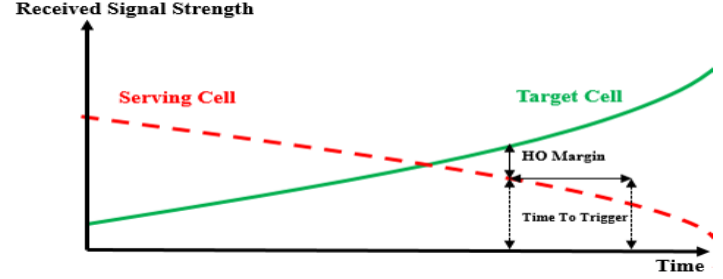
Figure 7. A sketch of near-far effect in different scenarios in